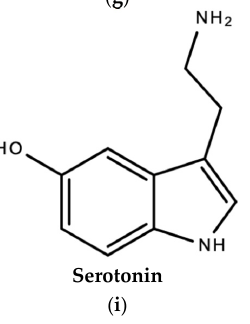
Figure 1. Chemical structures of classic serotonergic psychedelic compounds ( a – h ) and the neuro- transmitter serotonin ( i ). These substances all utilize the 5-hydroxytryptamine 2A